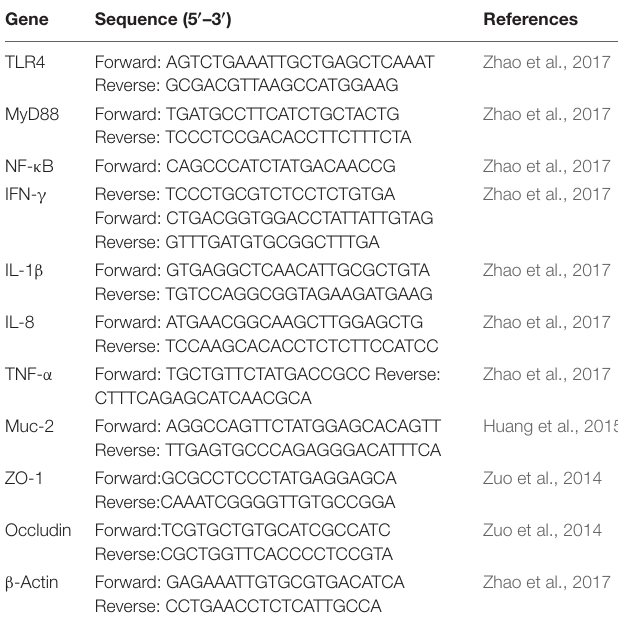
TABLE 2 | Primer sequences of targeted and reference